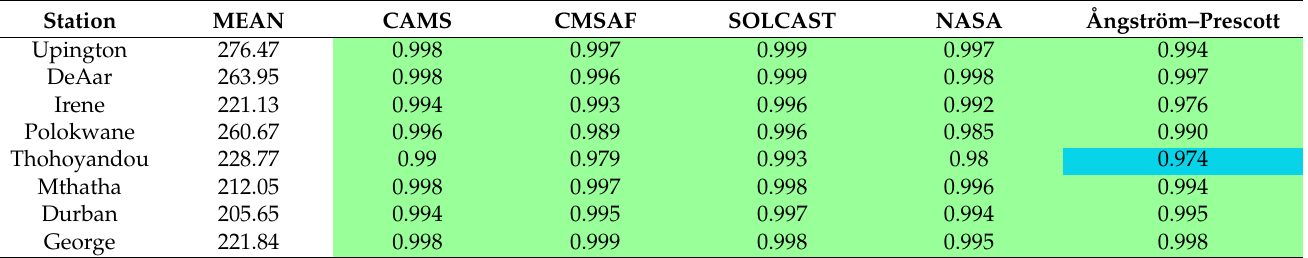
Table 5. The daily average observed GHI (W/m 2 ) and the correlation (R 2 ) between the estimated datasets and observed GHI in clear-sky conditions. Green is the best (0.925 ≤ R 2 ≤